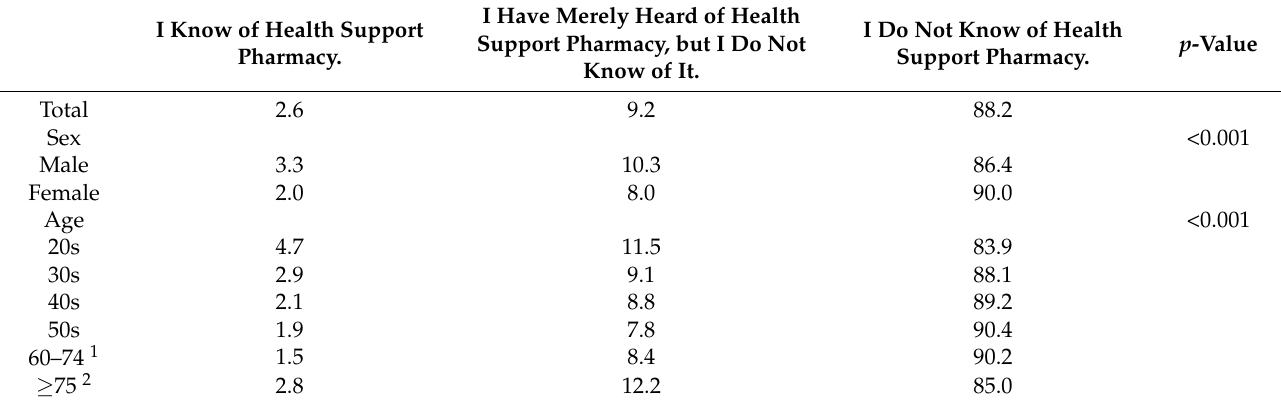
Table 2. Recognition of health support pharmacy.